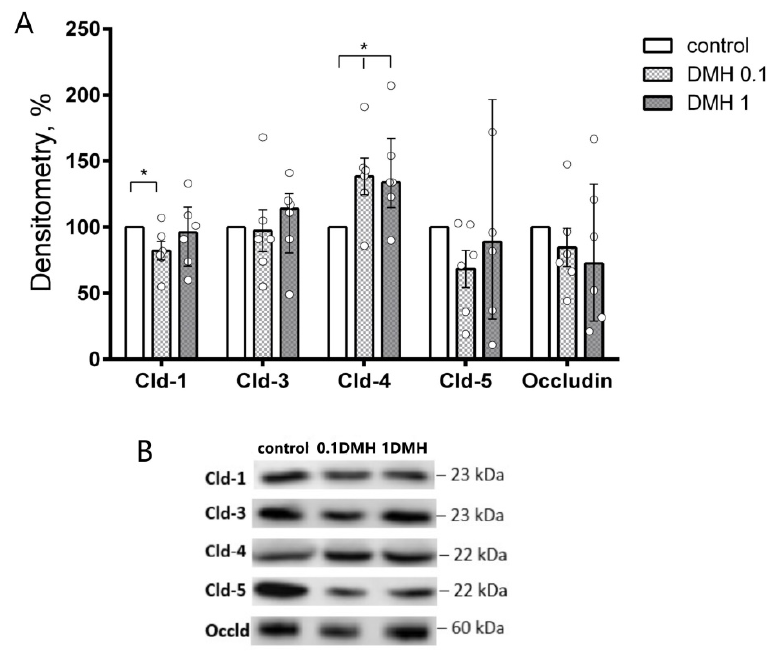
Figure 4. Western blot analysis of claudin expression in IPEC-J2 cell monolayers after 11 d incuba- tion with DMH. ( A ) densitometric analysis revealed increased Cld-4 signals in both 0.1 and 1 μ M DMH approaches vs. control, and decreased Cld-1 signals after incubation with 0.1 μ M DMH ( n = 6 in each group). The number of symbols corresponds to the number of samples. ( B ) representative Western blot bands. Data (mean ± SEM); * p < 0.05, Mann–Whitney U-test.